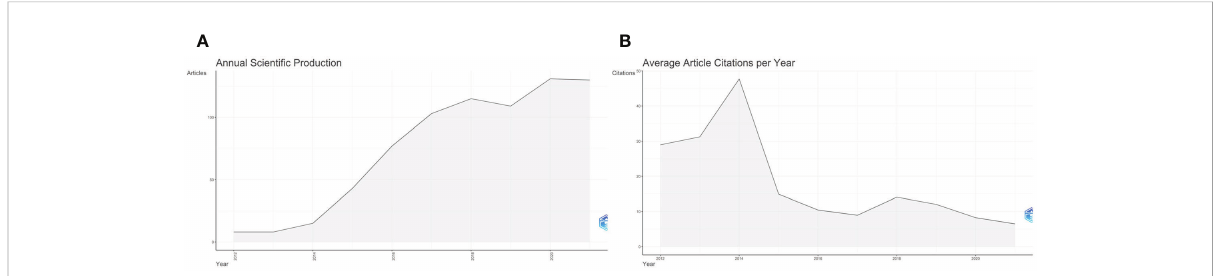
FIGURE 2 Annual publication and average article citations per year of ctDNA in the fi eld of breast cancer from 2012 to 2021. (A) Annual publication from 2012 to 2021 in this fi eld; (B) Average article citations per year from 2012 to 2021 in this fi eld.